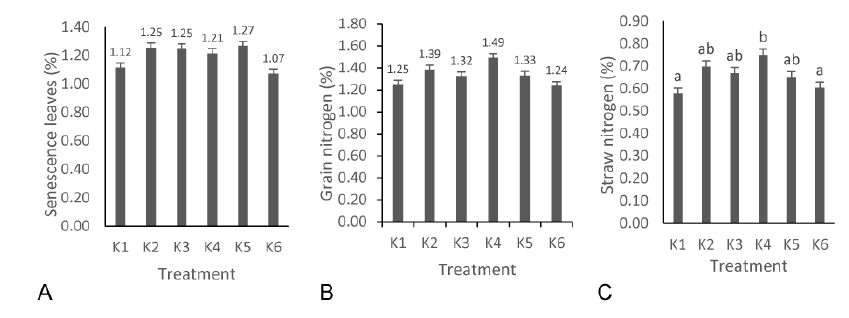
Figure 4 Nitrogen contents of senescent leaves ( A ), grains ( B ), and straw ( C ). Bars (means (cid:6) standard deviation; n = 3) with different letters are significantly different at LSD 0.05.